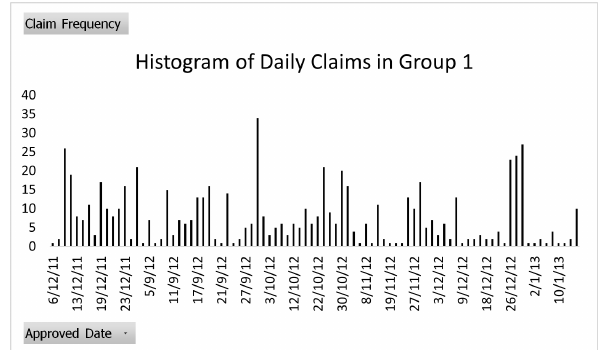
Figure 3. Histogram of Numbers of Claim Payments in Group 1.